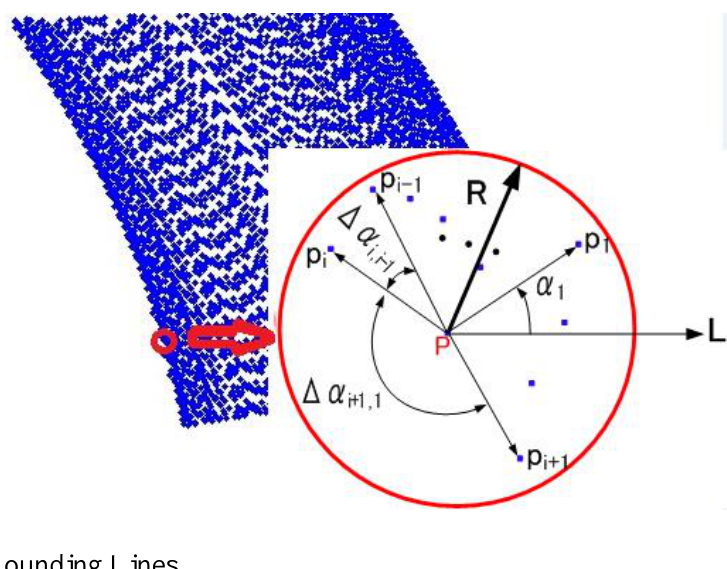
Figure 1. Extraction of boundary points using a moving